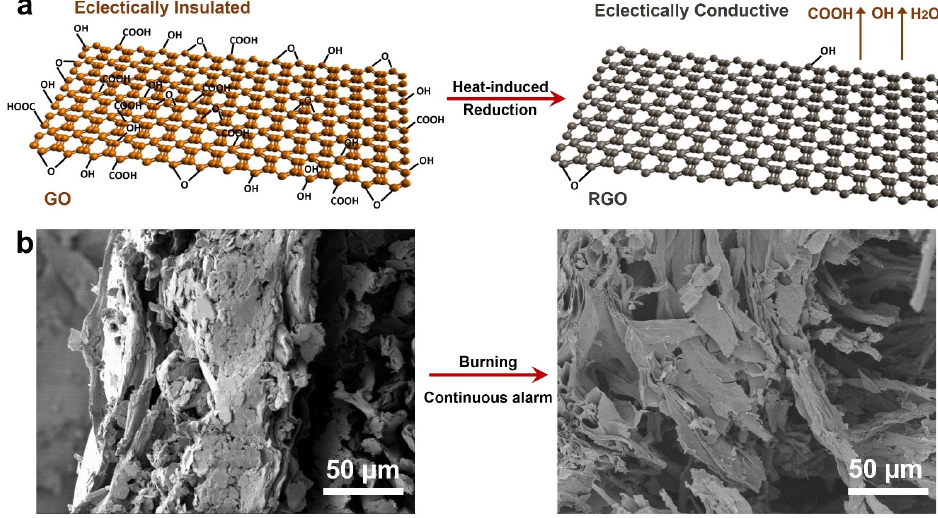
Figure 5. ( a ) Thermal-induced reduction of GO; ( b ) cross-section SEM images of GO/PDMAEMA/BN fabric before and after burning (Adapted with permission from Ref. [44]. 2021, John Wiley and